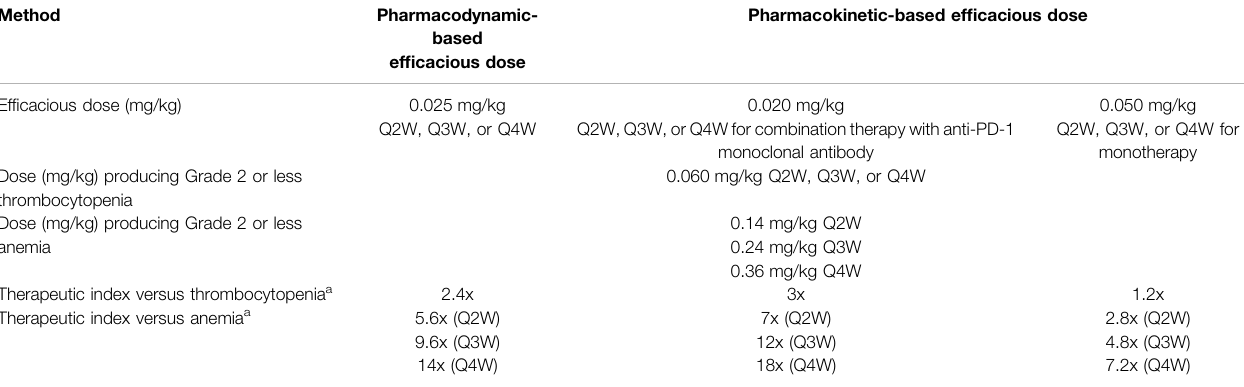
TABLE 4 | Therapeutic index of hFc-hIL-10 in cynomolgus